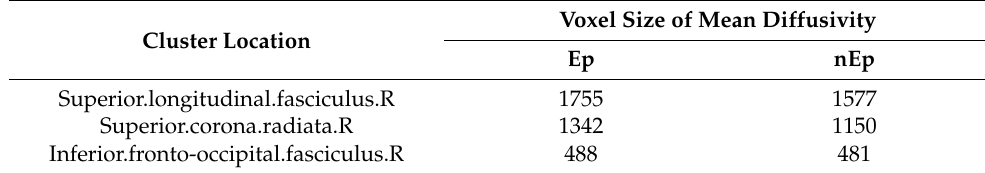
Table 2. Significant clusters with the most voxel count of mean diffusivity.